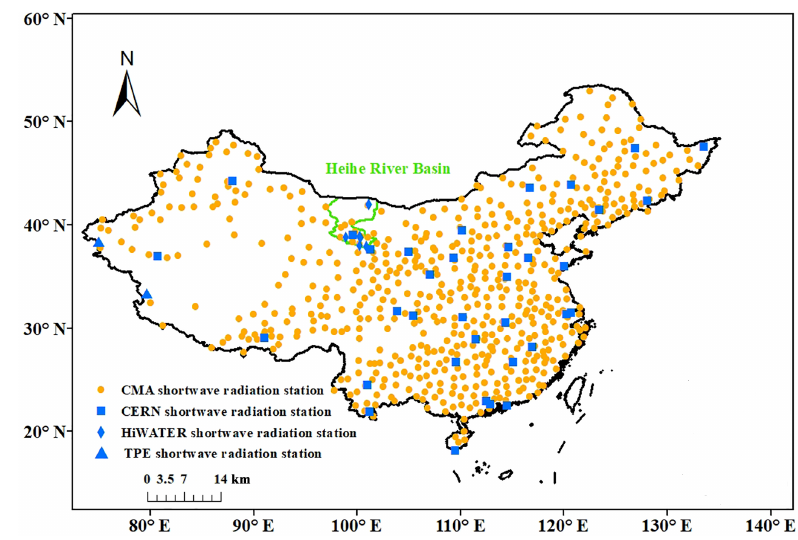
Figure 2. Locations of shortwave radiation stations in mainland China used to validate the forcing data sets.